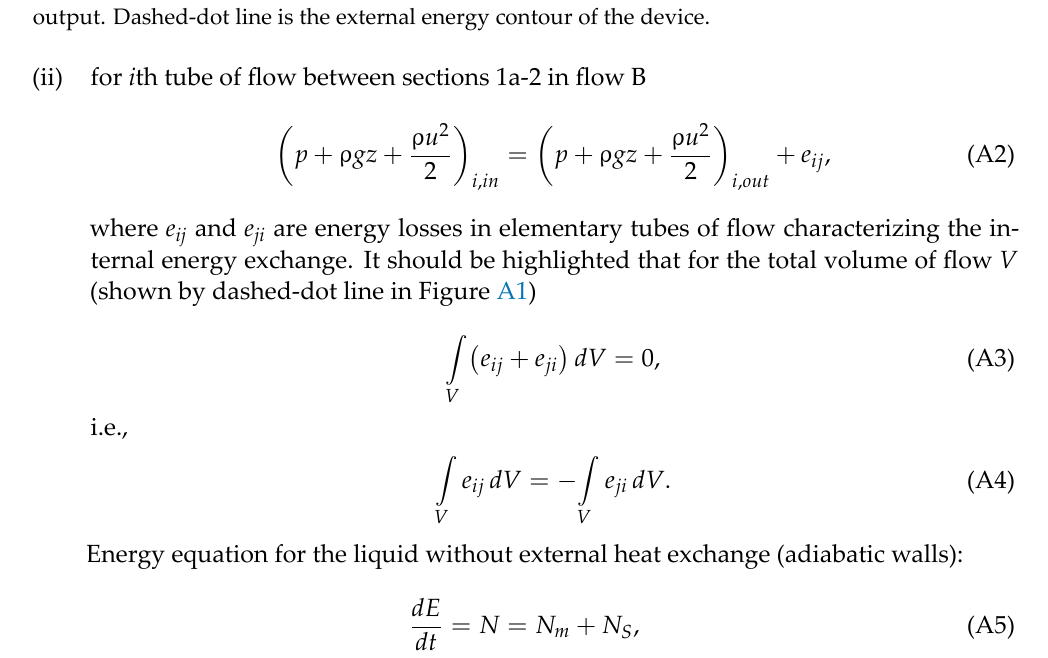
Figure A1. Schematic to the derivation of Bernoulli equation for the system with two inputs and one output. Dashed‑dot line is the external energy contour of the device.